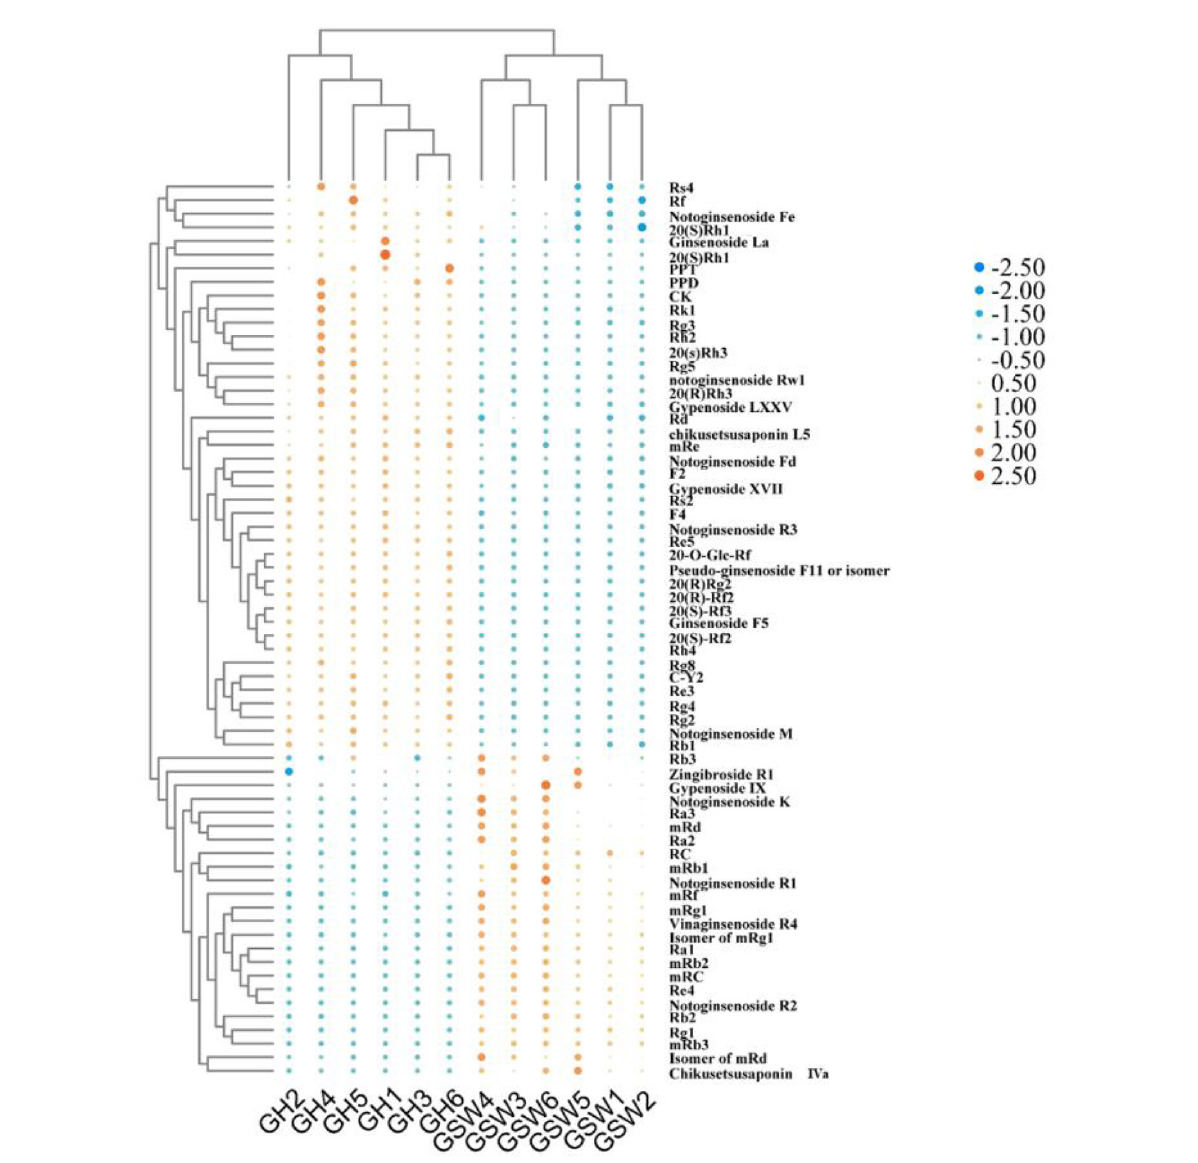
FIGURE8 Heat map and HCA clustering results of 67 non-volatile compounds with a significant difference ( p < 0.05) and aroma descriptors in ginseng wine samples fermented with different